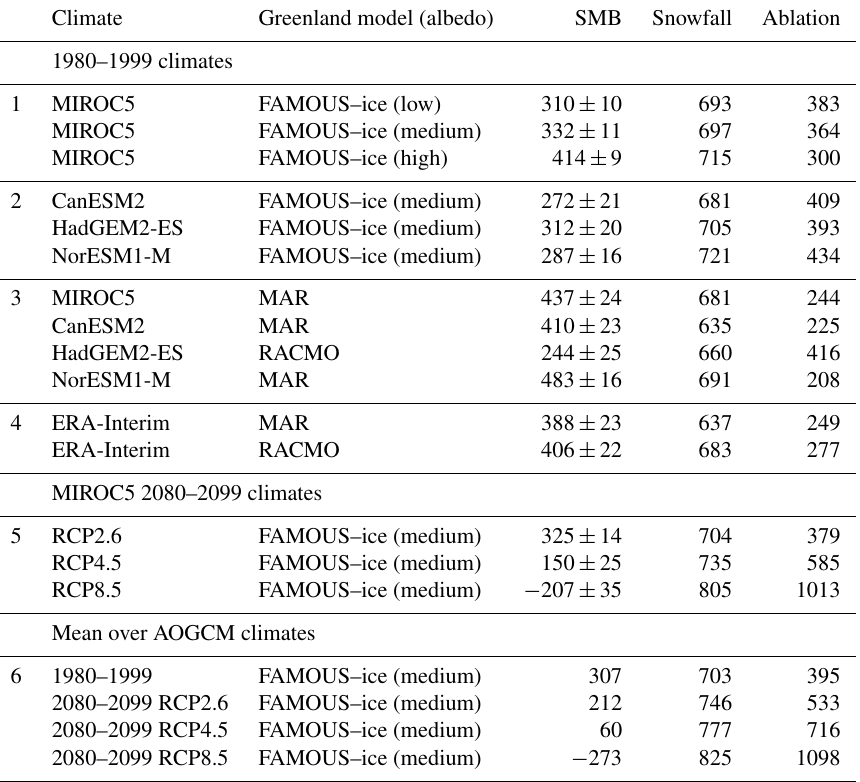
Table 1. Greenland area-integral surface mass balance (SMB), snowfall and ablation (all in Gtyr − 1 ) for FAMOUS–ice with MIROC5 AOGCM historical climate (with the three choices of FAMOUS–ice albedo), FAMOUS–ice with historical climates of other AOGCMs (FAMOUS–ice medium albedo only), the MAR and RACMO RCMs with the same AOGCM climates and with ERA-Interim climate (from Table 2 of Fettweis et al., 2013), FAMOUS–ice with MIROC5 AOGCM climate (medium albedo only) under RCP scenarios, and the FAMOUS–ice (medium albedo) mean over available AOGCMs for each climate (no HadGEM2-ES for RCP8.5, all four AOGCMs in other cases). The first column identifies the “groups” of results into which the table is divided; we refer to these group numbers in the text. Ablation is SMB − snowfall, mainly run-off from snowmelt and including evaporation, sublimation, condensation and rainfall freezing in the snowpack (in the RCMs; all rainfall runs off in FAMOUS–ice). The ± uncertainty shown for SMB is the standard error in the time mean, estimated by assuming annual values to be independent. The SMB from FAMOUS–ice has smaller standard errors than from the RCMs for two reasons. First, the FAMOUS–ice simulations exclude interannual variability due to SST and sea ice by using climatological mean BCs. Second, the RCM time means use 20 years of data, while we use 100 years for the FAMOUS–ice MIROC5 1980–1999 simulations, which supply our initial steady states, and 30 for other FAMOUS–ice simulations, which are transient